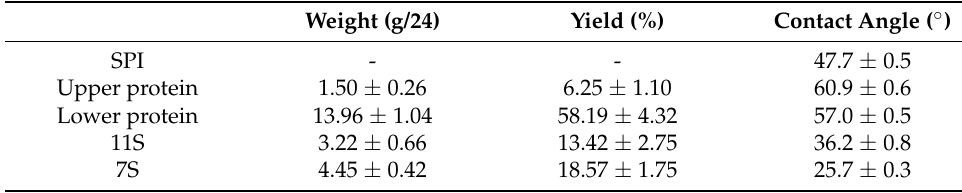
Table 1. Yields and contact angles of the samples.